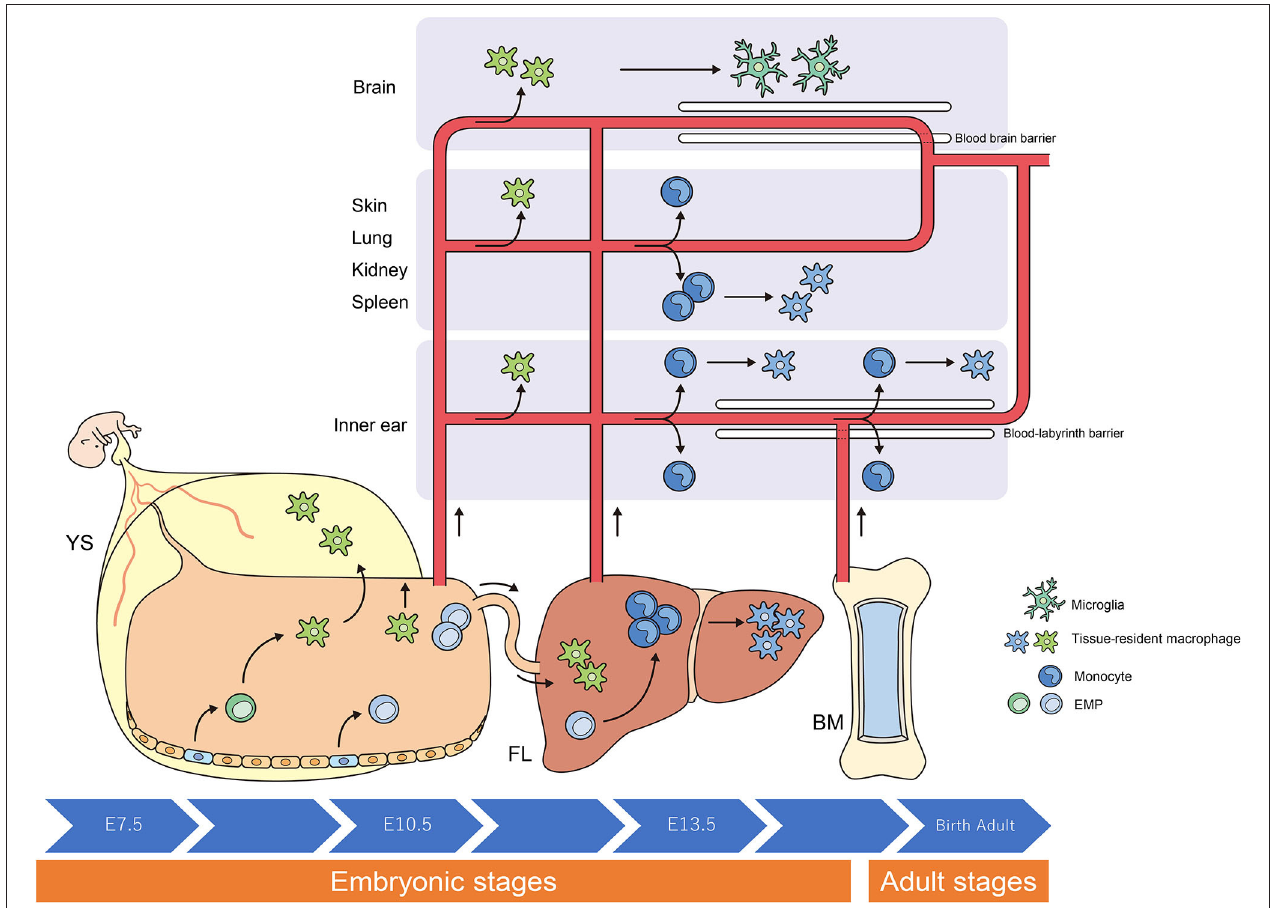
FIGURE 1 | Origins and renewal of tissue-resident macrophages. The latest destiny-mapping studies in mice imply that M ϕ s derived from the YS during early embryogenesis contribute to pools of mature tissue M ϕ s that include Langerhans cells and microglia. Further seeding in different tissues occurs following definitive hematopoiesis in the FL or BM. Proliferative local expansion of tissue M ϕ s within the neonatal period, followed by low-level self-renewal throughout adulthood, appears sufficient for maintaining many tissue-resident M ϕ populations. By helping to resolve acute inflammation, local proliferation may contribute to restoring homeostatic tissue-resident M ϕ populations. Although the exact contribution of BM-derived inflammatory M ϕ s to these tissue-resident pools remains unclear, it nonetheless appears to take place, perhaps in a tissue-specific manner. YS, yolk sac; FL, fetal liver; BM, bone marrow; EMP, erythro-myeloid progenitor; M ϕ ,